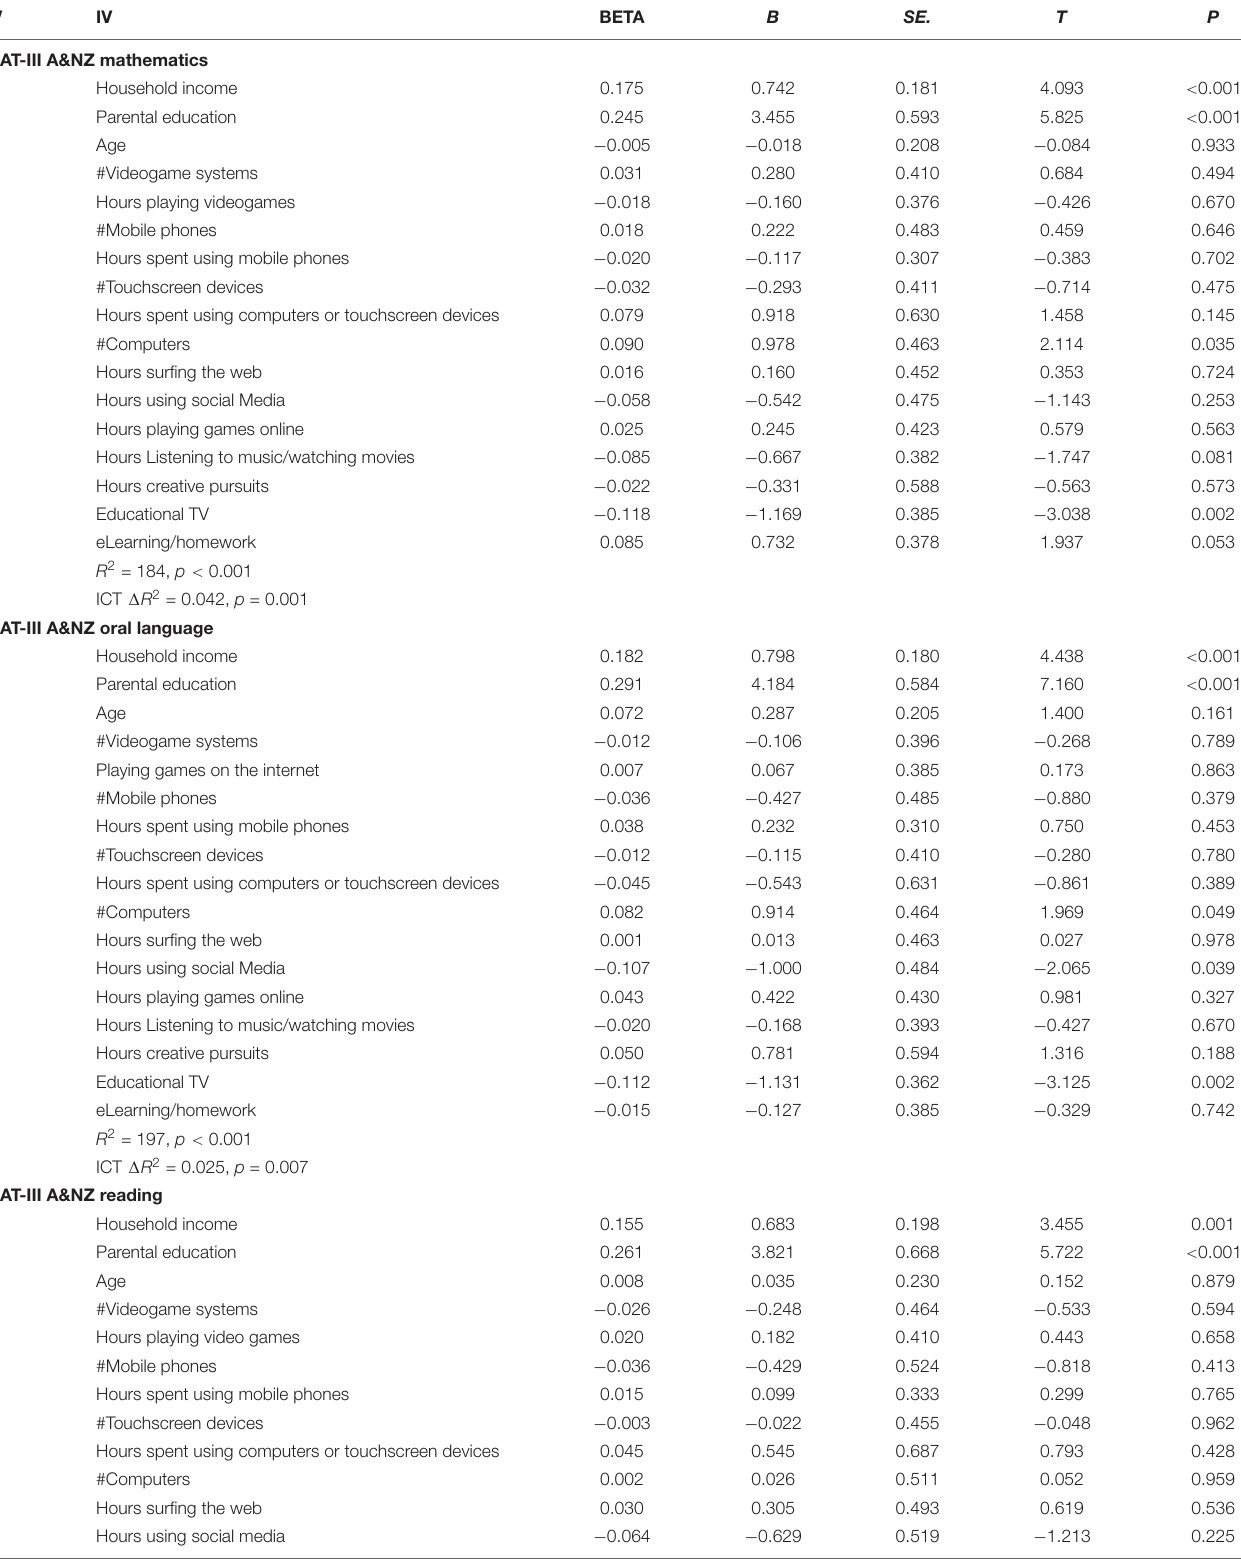
TABLE 7 | Combined model of ICT variables for WIAT-III A&NZ academic